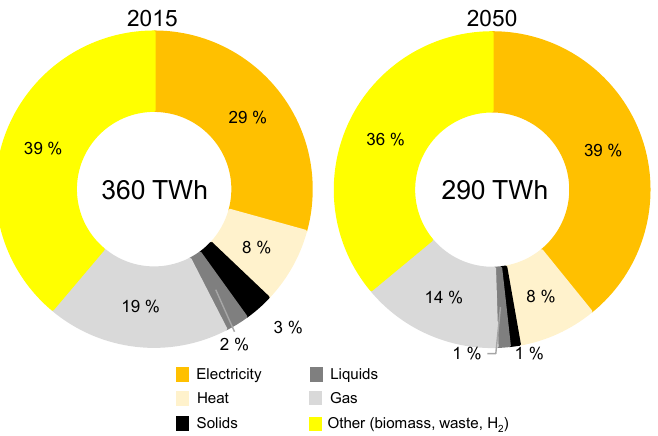
Figure 1. Energy use in the European pulp and paper industry in 2015 and 2050. Data from European Commission [19].